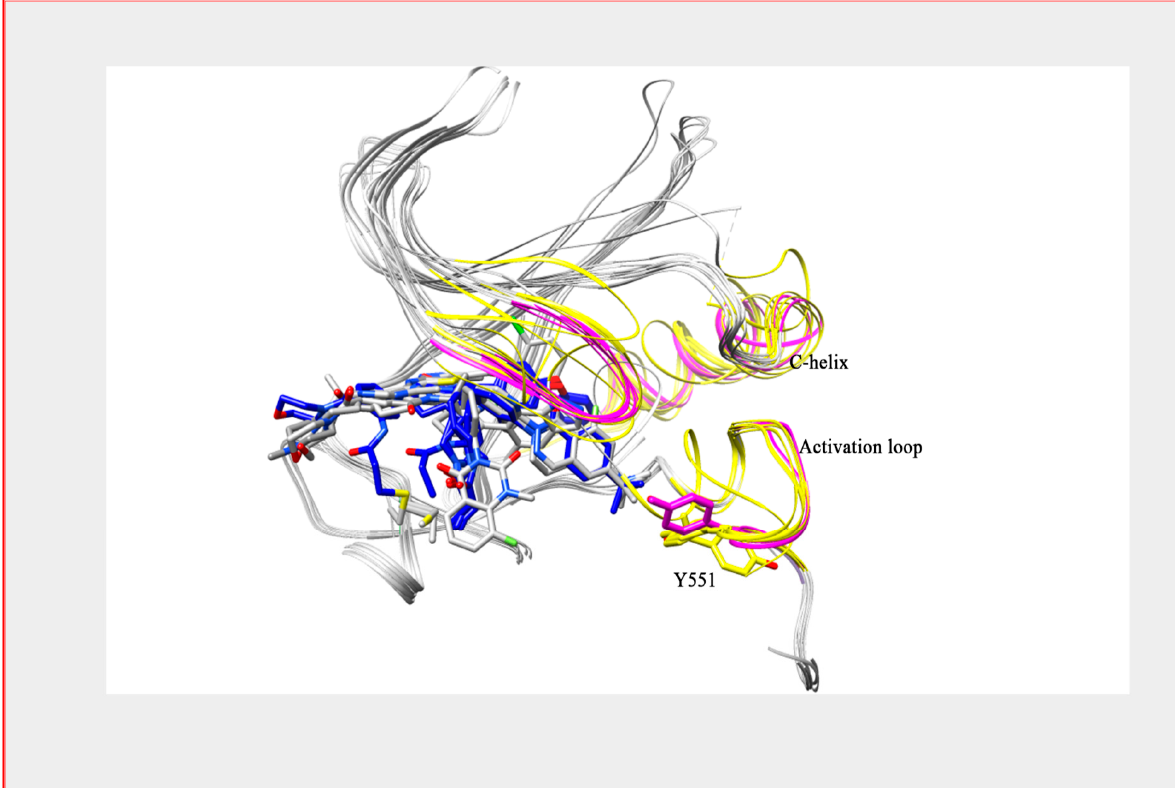
Figure 5. BTK structure with reversible and irreversible inhibitors. Superimposed structure of BTK kinase domain bound with both a reversible (colored grey) and irreversible inhibitor (colored blue). Secondary structure differences are shown in yellow (reversible) and magenta (irreversible) colors. The structure shows a structure difference at the C-helix and activation loop region.